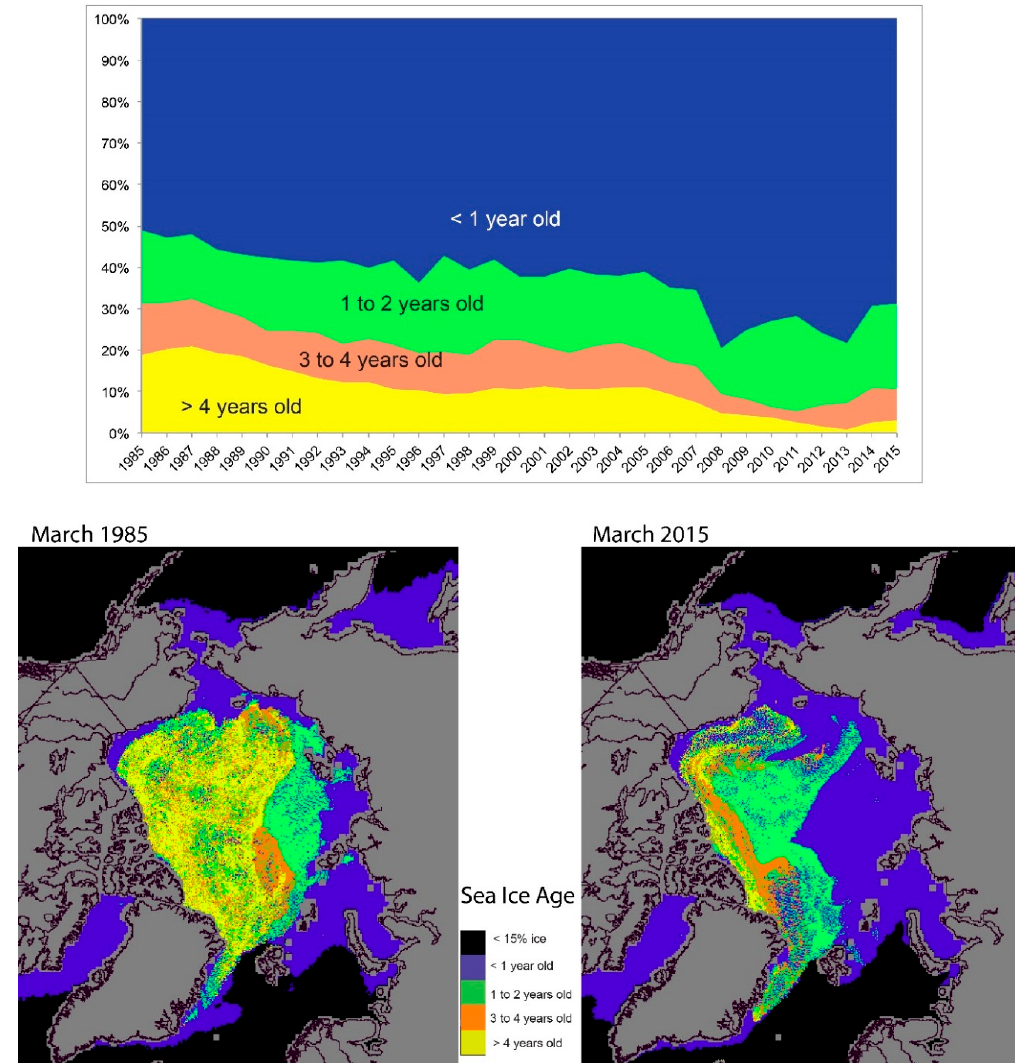
Figure 4. Sea ice age fraction for March 1985–2015 ( top ), and maps for March 1985 and 2015 ( bottom ) from the Univ. of CO sea ice age product (NSIDC, 2015). Figure by J. Maslanik, in the sea ice section of the Arctic Report Card, 2015 [30].